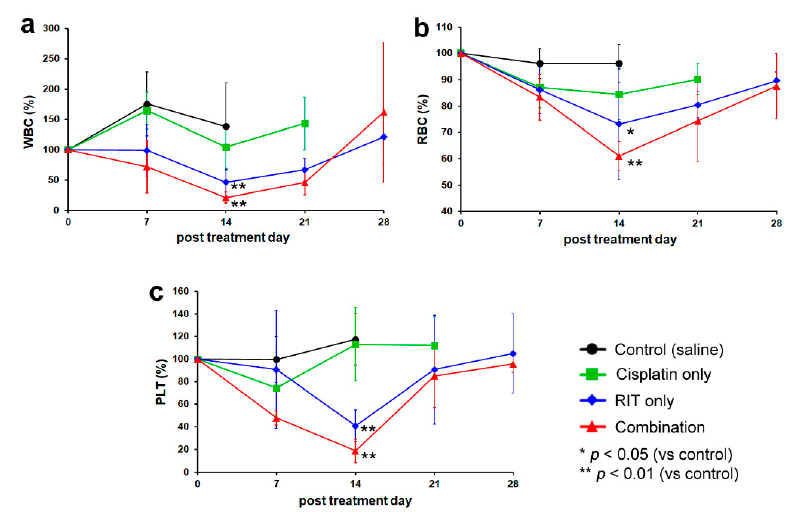
Figure 2. Peripheral blood count trends across distinct treatment groups. ( a ) Change in white blood cell (WBC) count; ( b ) Change in red blood cell (RBC) count; ( c ) Change in platelet (PLT) count. Black represents the control group, green represents the cisplatin-only group, blue represents the RIT-only group, and red represents the combination treatment group. * p < 0.05 (vs. control group), ** p < 0.01 (vs. control group).